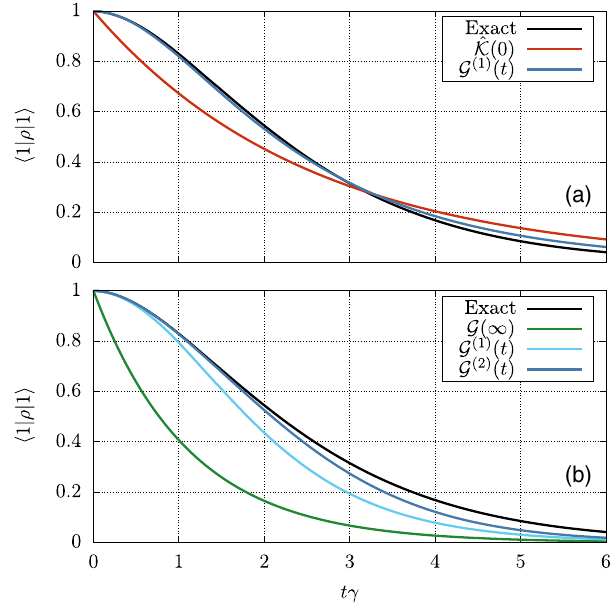
FIG. 2. Jaynes-Cummings model, overdamped regime Γ = γ ¼ 0 . 495 ( γ 0 = γ ¼ 0 . 1 ). Decay of the probability h 1 j ρ ð t Þj 1 i for the excited state when it is initially occupied, ρ ð 0 Þ ¼ j 1 ih 1 j . (a) Sol- utions obtained from the Markovian approximation _ ρ ð t Þ ≈ − i ˆ K ð 0 Þ ρ ð t Þ (red line) together with the first iteration G ð 1 Þ (cyan line) of the transient fixed-point equation starting from G ð 0 Þ ¼ ˆ K ð 0 Þ . The exact solution is shown in black. (b) Solutions obtained from the Markovian approximation _ ρ ð t Þ ≈ − i G ð ∞ Þ ρ ð t Þ (blue line) together with two iterations of the transient fixed-point equation (30), G ð 1 Þ (cyan line) and G ð 2 Þ (green line), when started from G ð 0 Þ ¼ G ð ∞ Þ and exact solution (black